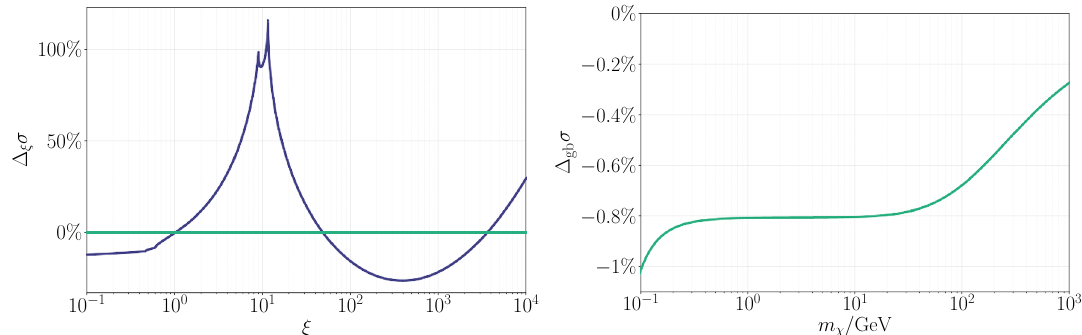
Figure 13 . Left: The relative change of the SI cross section as defined in eq. (5.10) is shown as a function of the gauge parameter ξ . The green line indicates the result calculated in our presented approach and the blue line corresponds to the approach including the additional gluon contributions discussed in section 4.2.6. Right: The relative change of the SI cross section as defined in eq. (5.11) as a function of the DM mass m χ